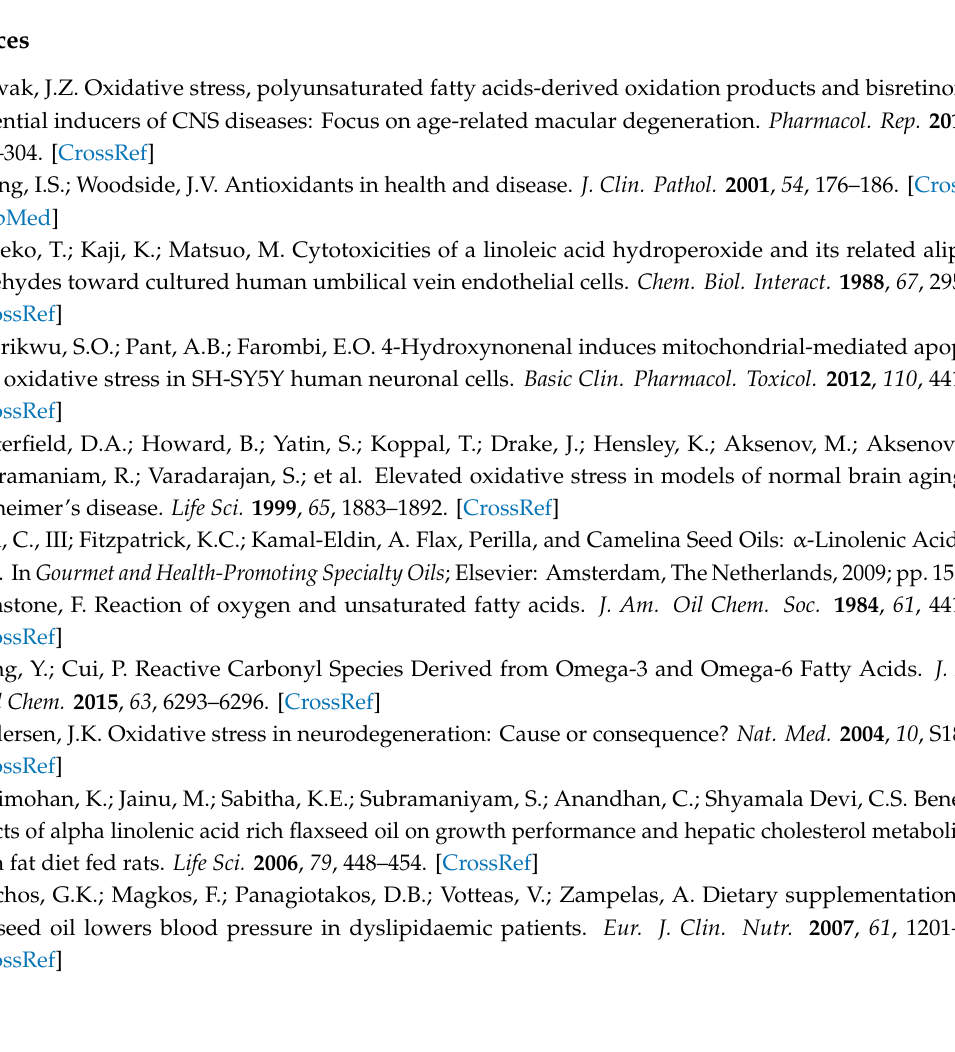
Figure S1: Additional information and data of flow cytometric analysis of apoptosis using Annexin V-FITC and